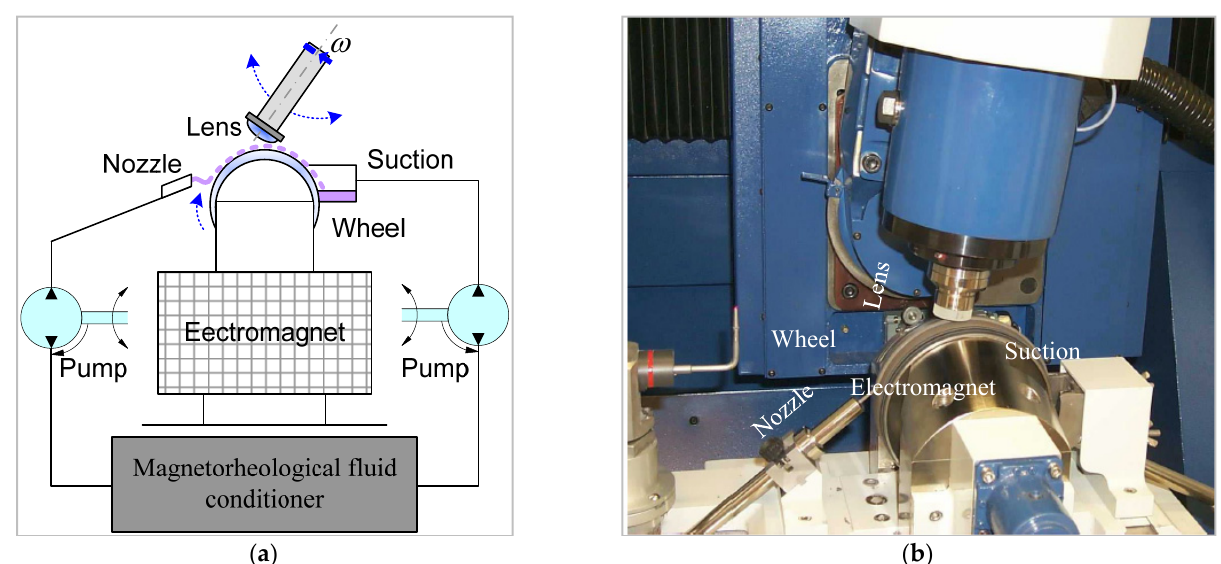
Figure 7. ( a ) Principle of the Q22 multiple-axis computer-controlled magnetorheological finishing (MRF) machine, ( b ) photography of the MRF machine. Table 3. Typical mechanical, optical and chemical properties of Zerodur ® [40].